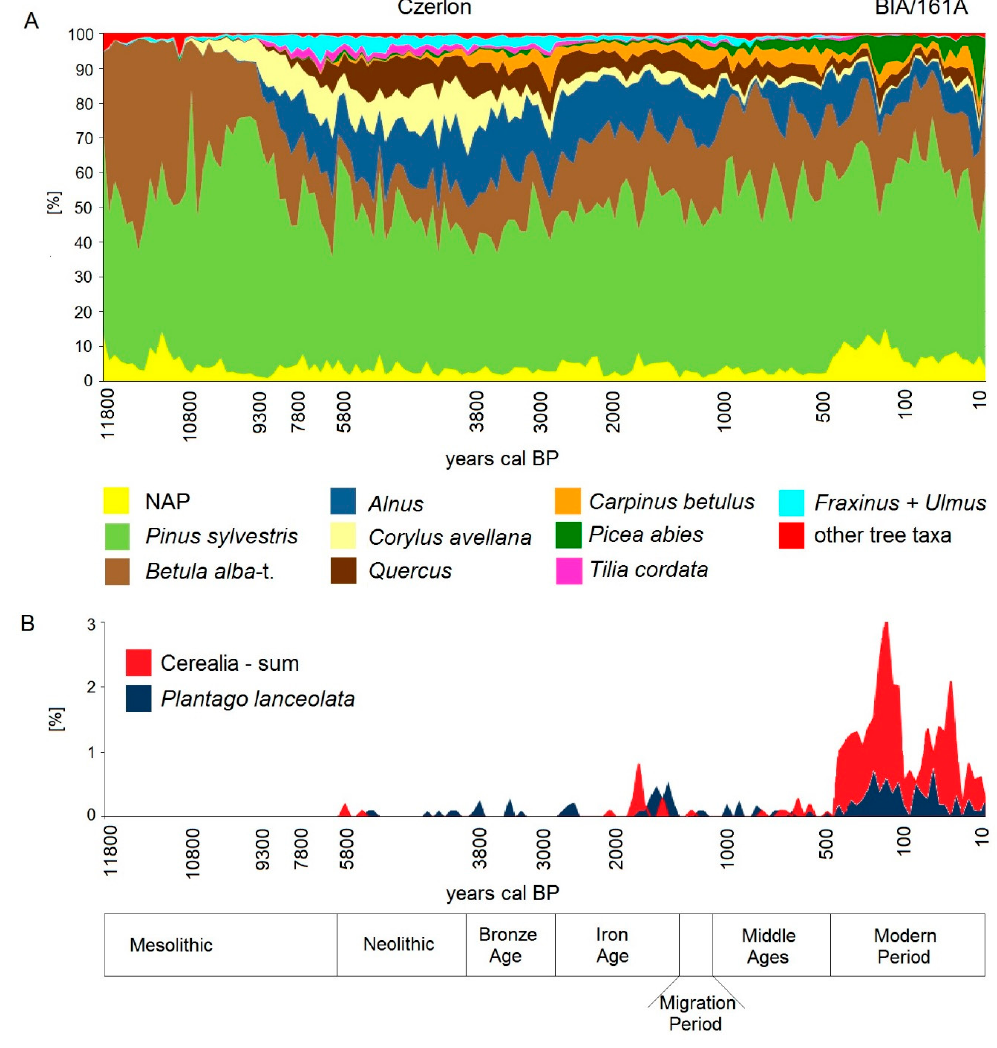
gradual expansion of Picea , which accelerated first at about 1.5 ka and then after 1 ka following anthropogenic and natural forest disturbances, and climatic shifts [57,120]. Interestingly, the BF Picea population which forms the south-western limit of the species’ present-day northern distribution